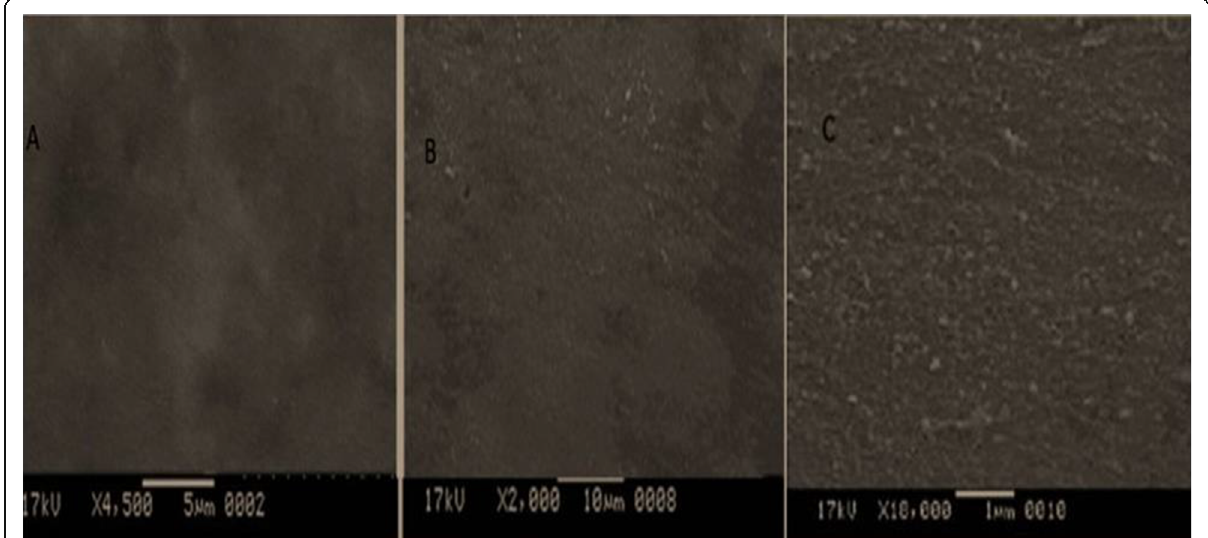
Fig. 5 SEM images of DIA patch at A 0 months, B 6 months under room temperature, and C 6 months under storage